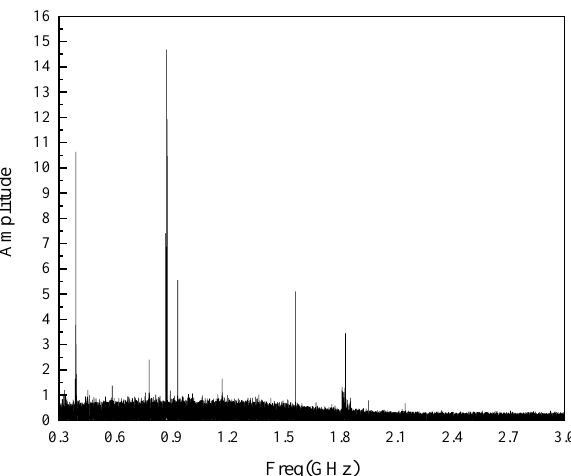
Figure 20. Spectrum diagram of PD signal of built-in experiment.